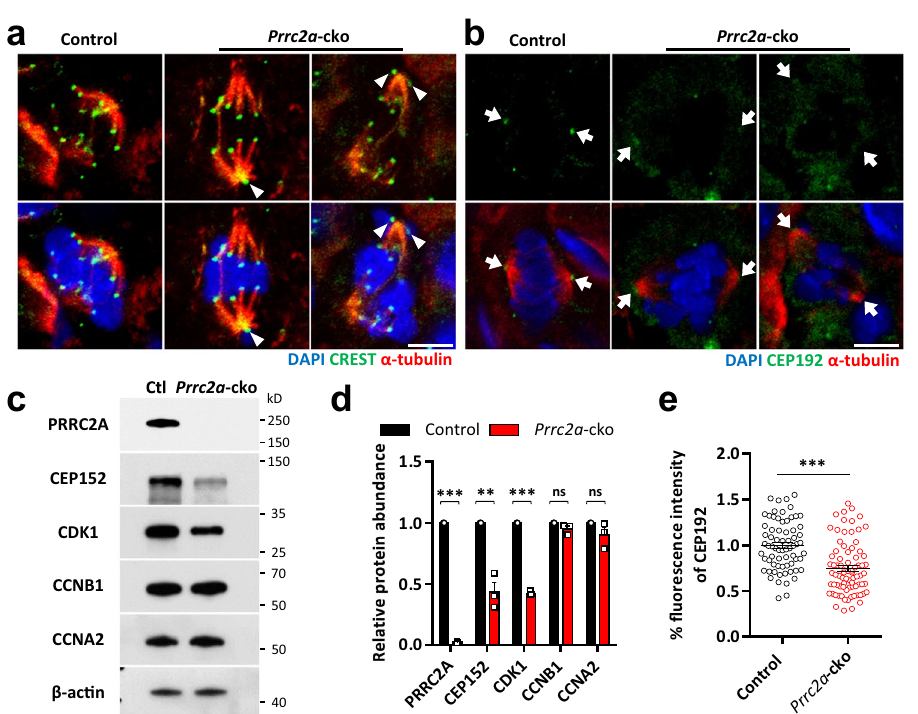
Fig. 4 | PRRC2A de fi ciency leads to impaired centrosome and downregulation ofMPF.a RepresentativemetaphaseIspermatocytesinP60controland Prrc2a -cko testes sections immunostained with CREST and α -tubulin. Scale bar, 5 μ m. b Representative metaphase I spermatocytes in P60 control and Prrc2a -cko testes sections immunostained with CEP192, α -tubulin. Arrows indicate spindle poles. Scale bar, 5 μ m. c WB test of indicated proteins in control and PRRC2A-null sper- matocytes from mice. d Quanti fi cation of the relative level of indicated proteins in